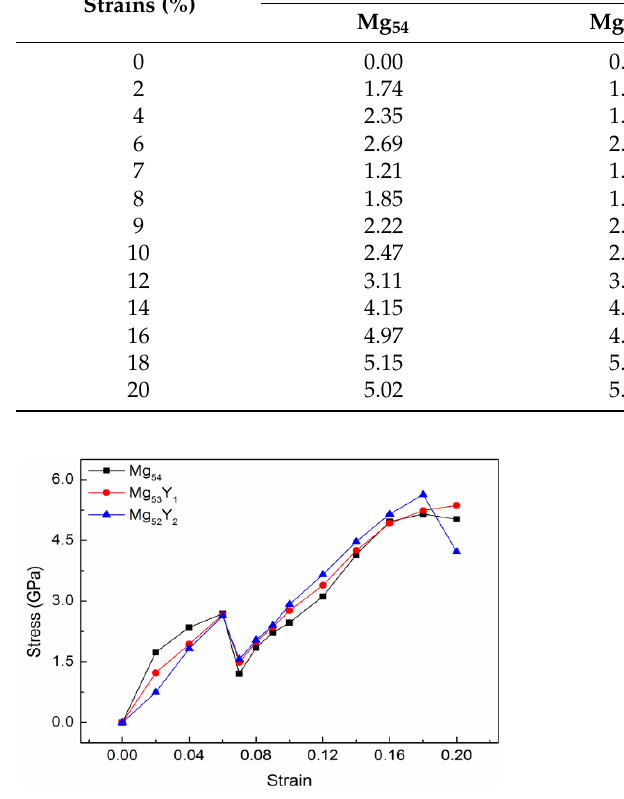
Figure 2. Stress-strain curve of Y Mg 54 , Mg 53 Y 1 and Mg 52 Y 2 .